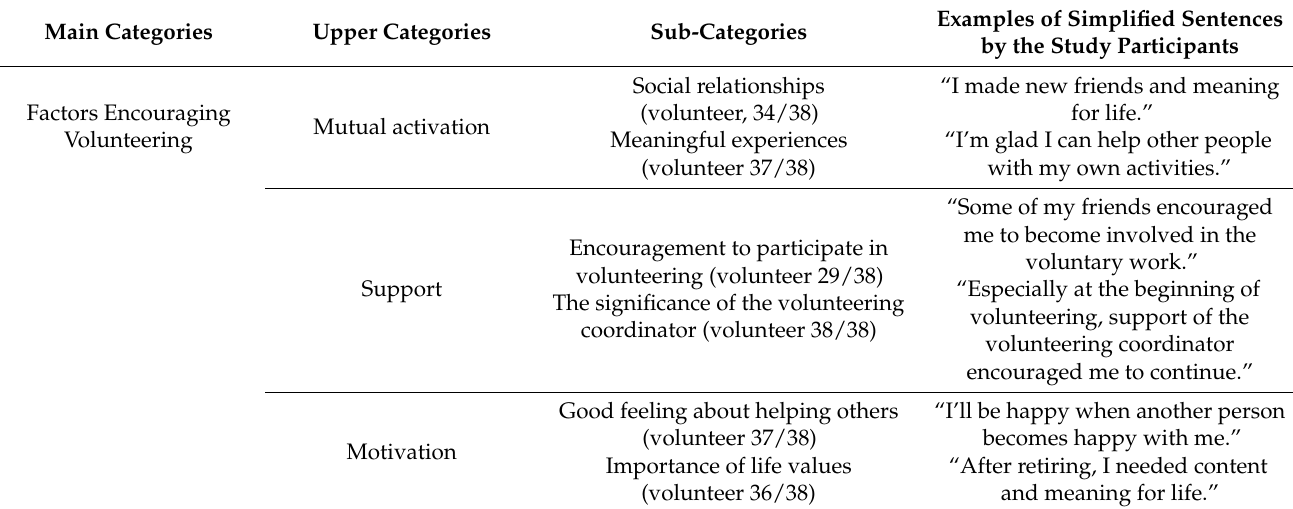
Table 3. Factors Encouraging Volunteering in Older